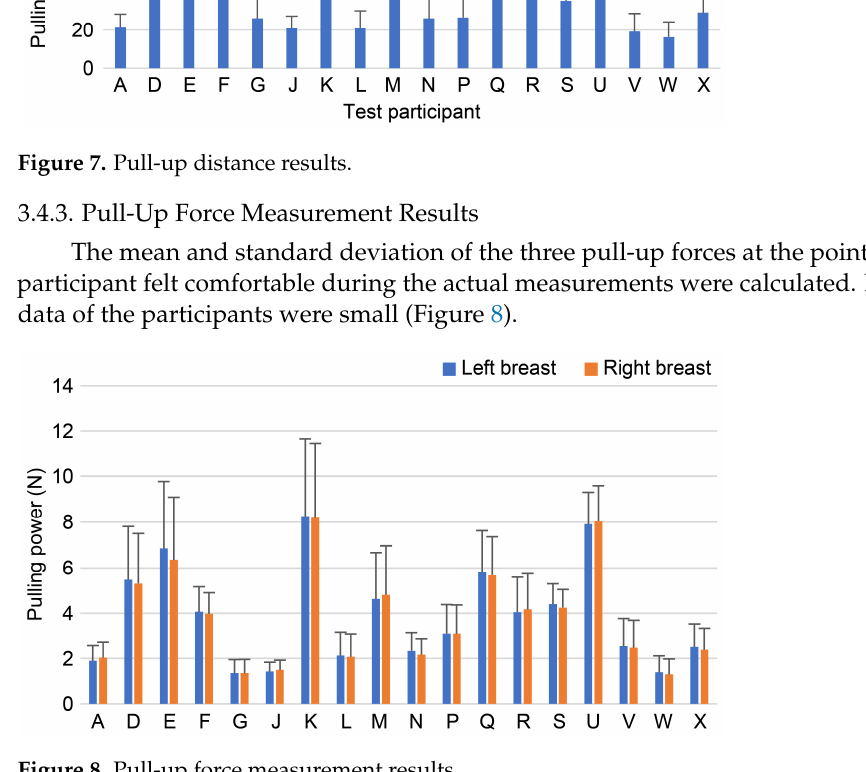
Figure 8. Pull-up force measurement results.